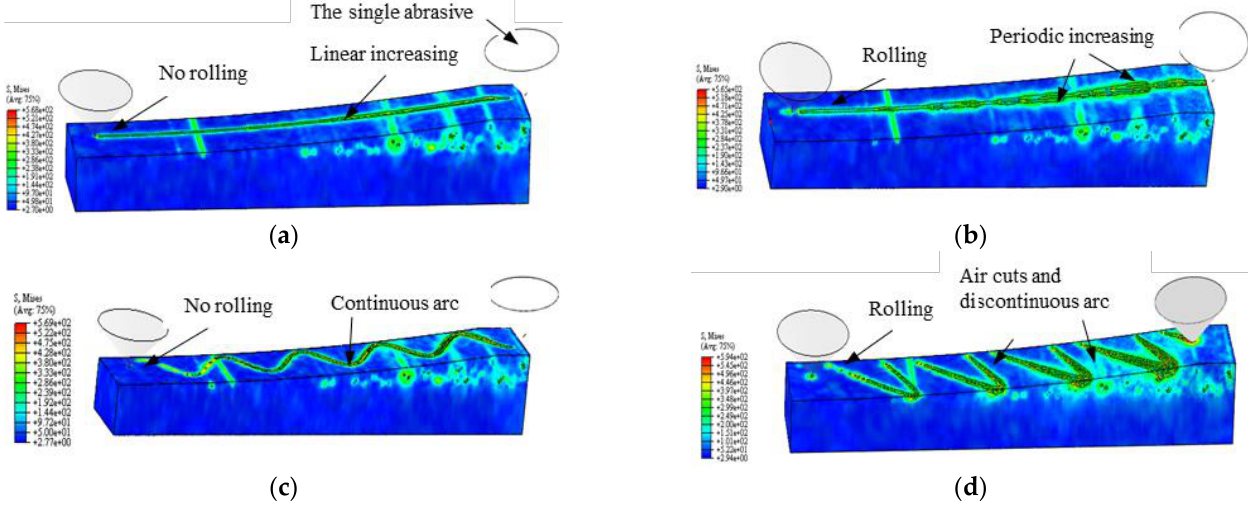
Figure 12. Simulation of an abrasive grinding process: ( a ) GM; ( b ) XUGM; ( c ) ZUGM; and ( d ) 2UGM.